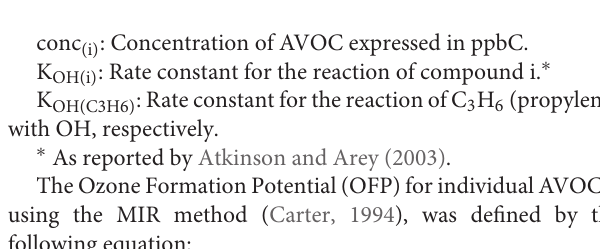
FIGURE 1 | Sampling sites in Santiago, Chile. (A) B Park ( L. tulipifera ); (B) VM Avenue ( L. tulipifera ); and (C) V Avenue ( Platanus sp). Red dots identify individuals sampled at each